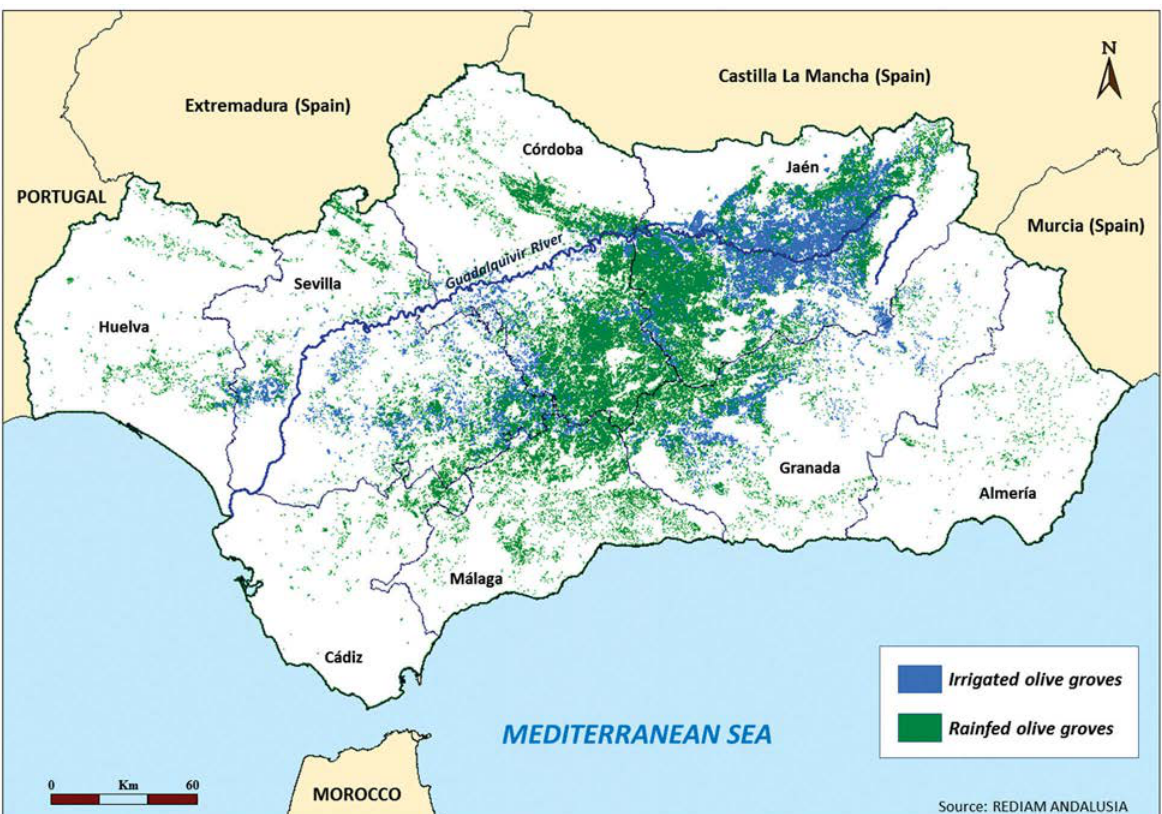
Fig. 1. Irrigated olive groves in the Guadalquivir river basin (Andalusia,